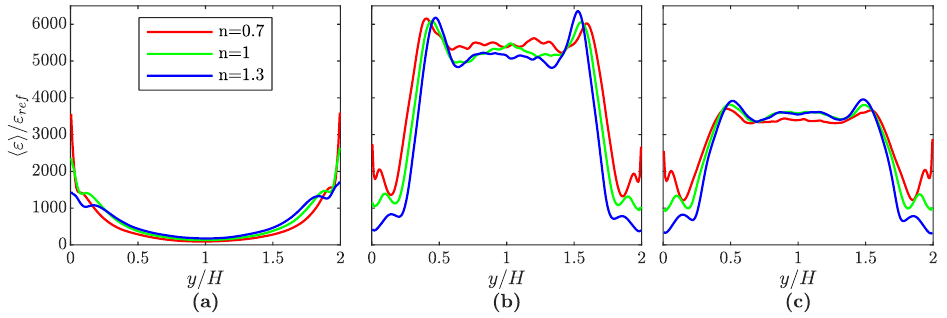
Figure 12. Average dissipation rate (cid:104) ε (cid:105) , normalized by ε ref , as a function of the wall-normal coordinate for the single-phase ( a ) and the two-phase setups with Eo = 0.3125 ( b ) and Eo = 3.75 ( c